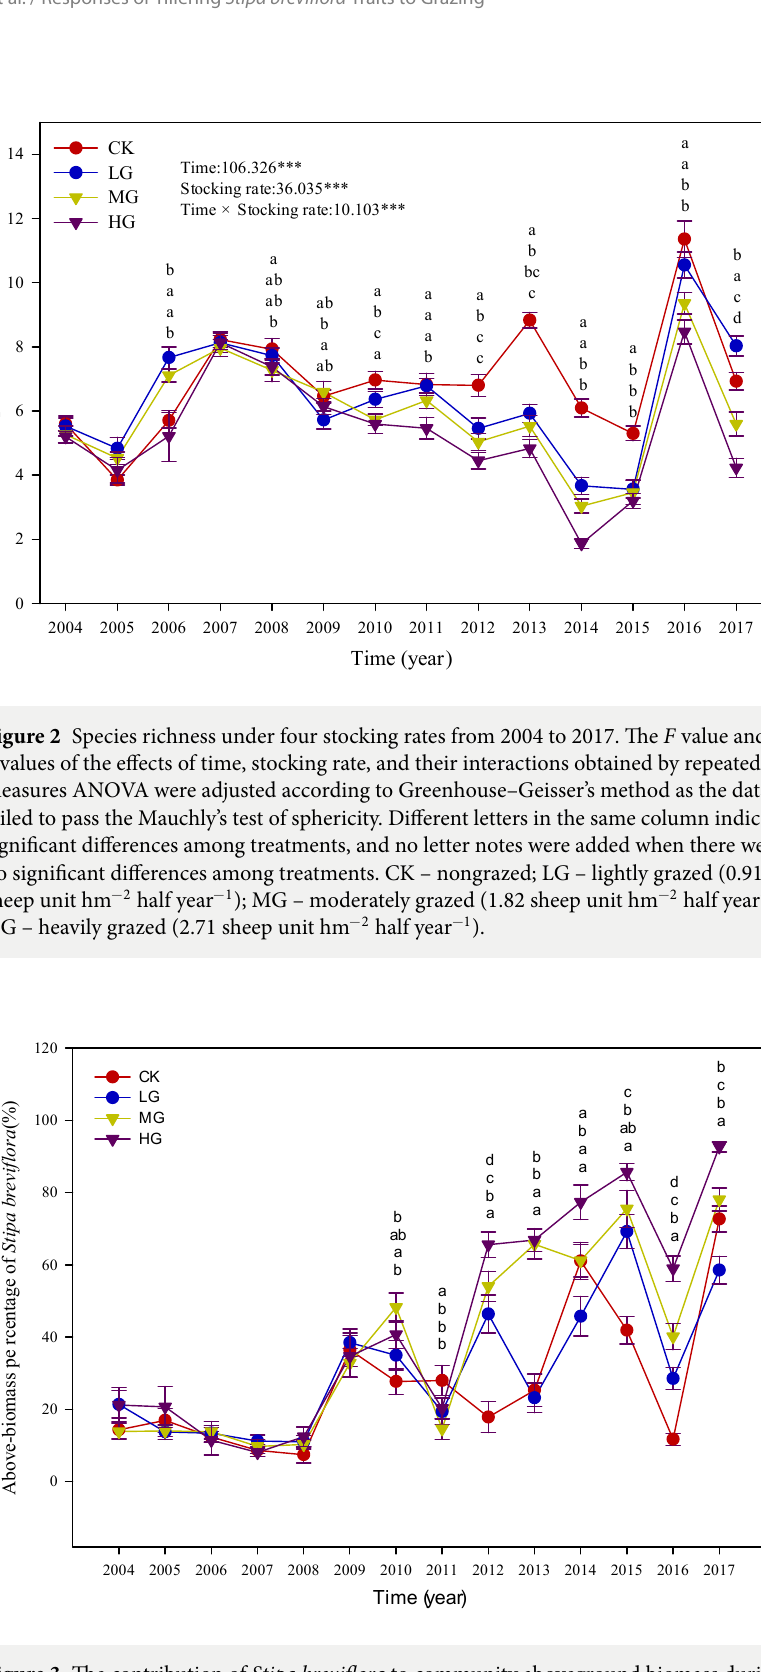
Figure 3 e contribution of Stipa breviflora to community aboveground biomass during 2004 to 2017. CK – nongrazed; LG – lightly grazed (0.91 sheep unit hm − 2 half year − 1 ); MG – moderately grazed (1.82 sheep unit hm − 2 half year − 1 ); HG – heavily grazed (2.71 sheep unit hm − 2 half year − 1